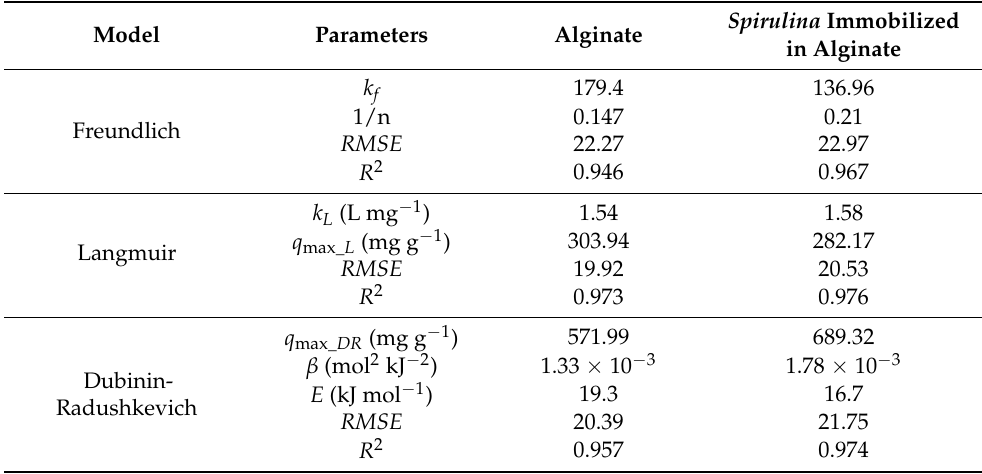
Table 3. Equilibrium isotherm parameters for the biosorption of Pb (II) on alginate and Spirulina immobilized in